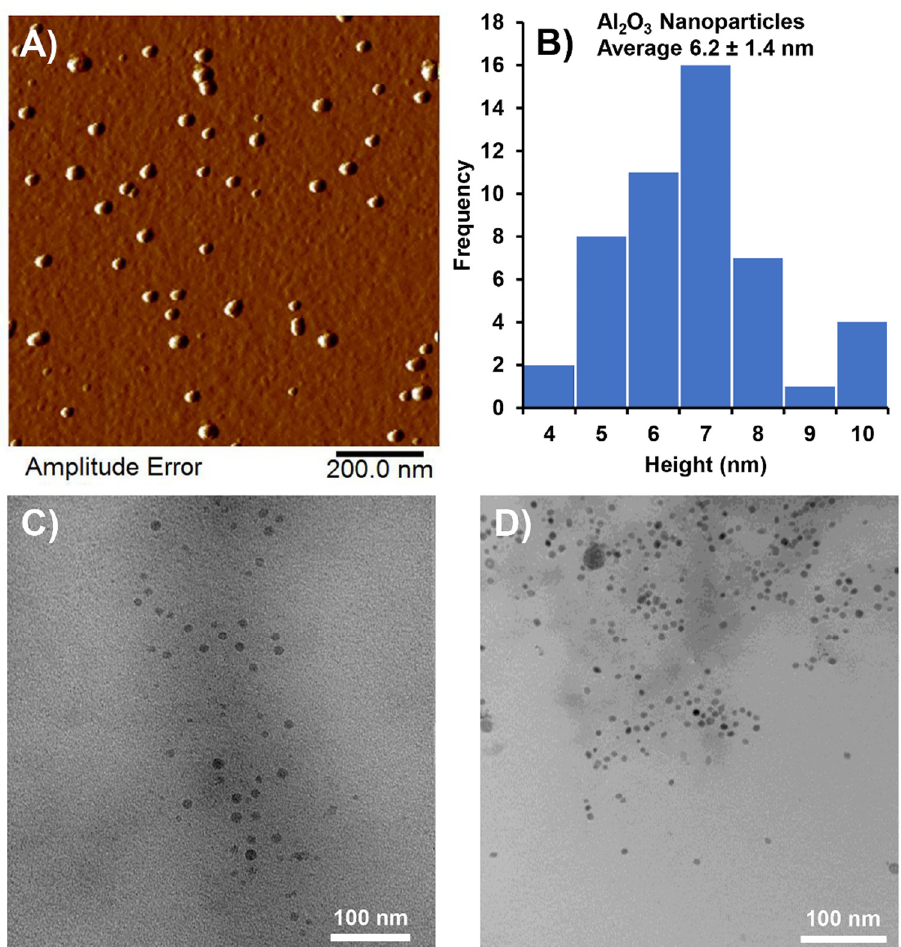
Figure 2. Characterization of synthesized Al 2 O 3 nanoparticles. ( A ) AFM image of Al 2 O 3 nanoparti- cles, ( B ) Al 2 O 3 nanoparticle size distribution, ( C ) TEM image of Al 2 O 3 nanoparticles before annealing, and ( D ) TEM image of Al 2 O 3 nanoparticles after annealing at 700 ◦